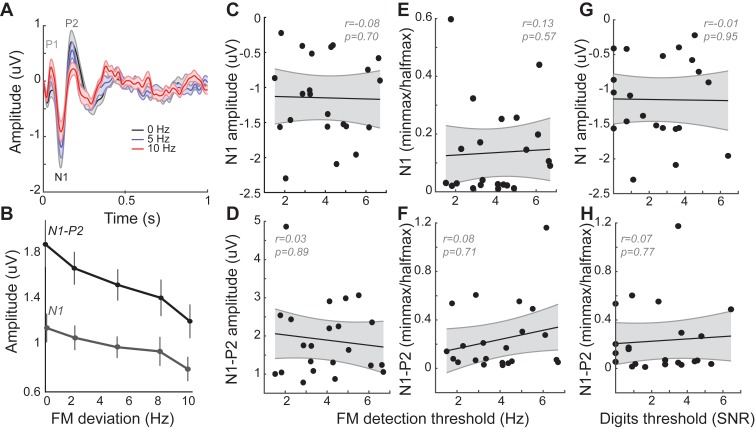
Cortical event-related potentials (ERPs) are modulated by FM stimuli, but not related to behavioral performance.(A) Grand averaged ERPs recorded to FM tones from the Fz – tiptrode electrode montage show clear P1-N1-P2 peaks with associated latencies. (B) Peak amplitudes are modulated by FM modulation depth, with N1 amplitudes and N1-P2 amplitudes showing a decrease with larger FM deviations. (C–D) Absolute amplitudes for N1, and the N1-P2 elicited to pure tones (FM deviation of 0 Hz) were not correlated with behavioral performance on the FM detection task. (E–F) Slopes calculated from amplitude curves expressed as a fraction of the pure-tone phase-locking amplitude, in a manner similar to FMFRs (Figure 2F) were also not significantly correlated to behavioral performance on the FM task. (G–H) Neither the N1 amplitude nor the N1P2 slope were significantly correlated with performance on the digits task. These data demonstrate that whereas phase-locking to sTFS cues was significantly related to multi-talker speech perception, evoked potentials elicited by the same stimuli generated by downstream stages of auditory processing had no such relationship. However, these results should be interpreted with the caveat that the arousal states of the subjects were monitored but not controlled, and changes in arousal states can have significant effects on cortical ERP amplitudes.Figure 2—figure supplement 2—source data 1.ERP measures.